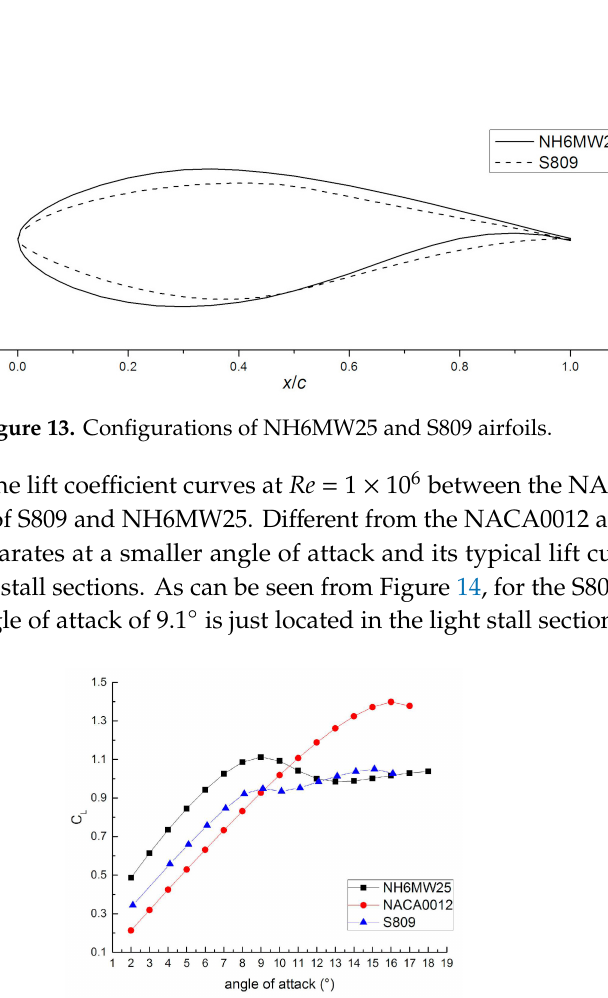
Figure 12. Particle concentration effects on lift-to-drag ratio of S809 airfoil at Re = 1 × 10 6 .